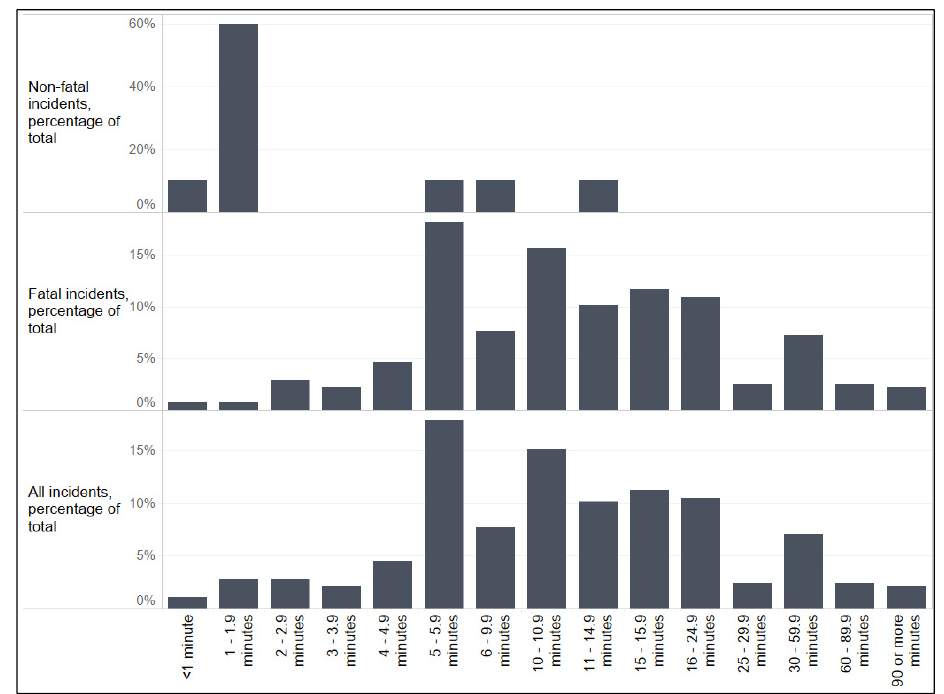
Figure 1. Reported inactive supervision time of U.S. children ages 0–13 submersion incidents investigated by the U.S. Consumer Product Safety Commission, 2000–2017 ( n = 285).